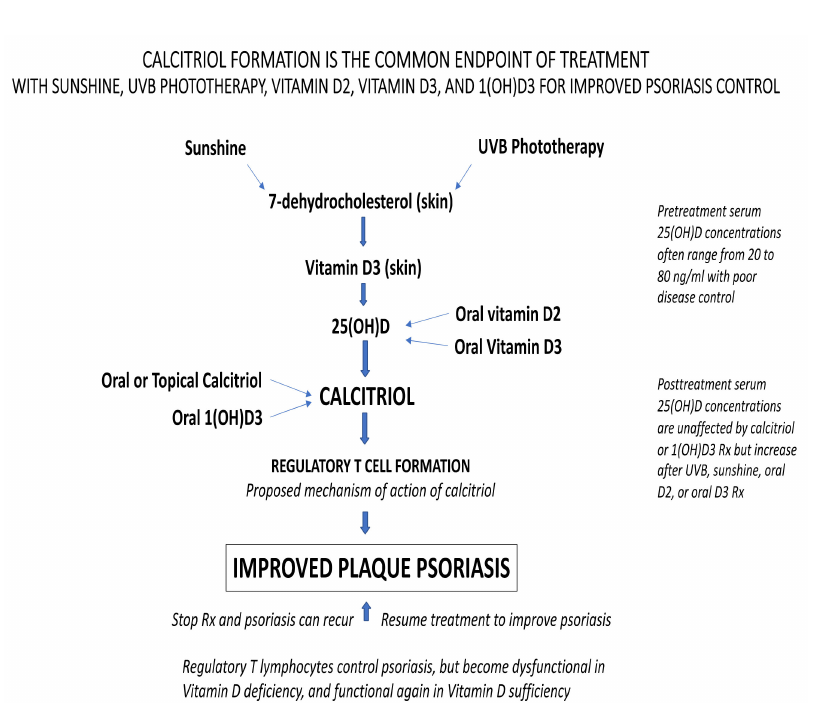
Figure 1. The metabolic pathway of calcitriol production from 7-dehydrocholesterol in the skin after interaction with UVB radiation present in sunshine or UVB